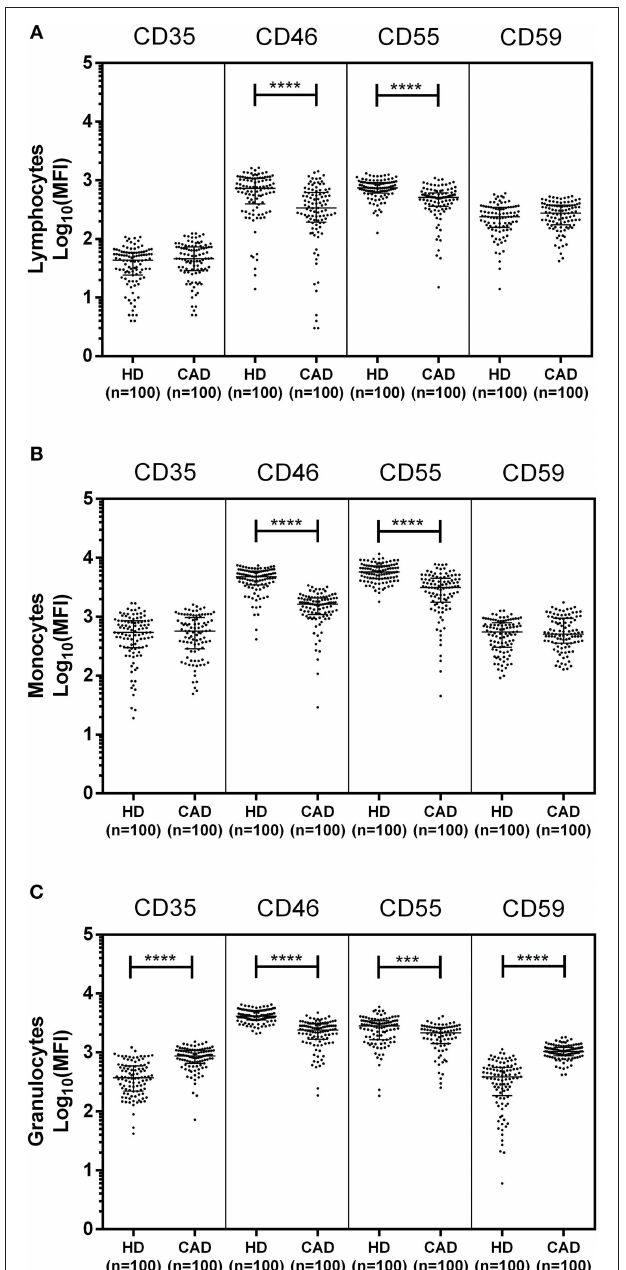
FIGURE 1 | Differential surface expression of complement regulatory proteins on leukocytic subsets of coronary artery disease patients. Surface expression of CD35, CD46, CD55, and CD59 on lymphocytes, monocytes, and granulocytes of healthy donors, and coronary artery disease patients was assessed by flow cytometry. Comparison of log-transformed median fluorescence intensity (Log 10 MFI) of CD35, CD46, CD55, and CD59 shows significantly lower surface expression of CD46, and CD55 on all leukocytic subsets of CAD patients (A–C) . CD35 and CD59 surface expression was significantly higher on granulocytes of CAD patients (C) . Mann-Whitney U test was used for comparison of values between groups. Three asterisks (***) indicate a p -value of < 0.001, and four asterisks (****) indicate a p -value of < 0.001.